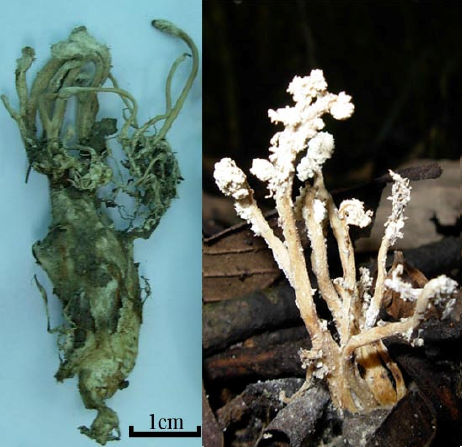
Figure 1. Cordyceps cicadae used for this study.